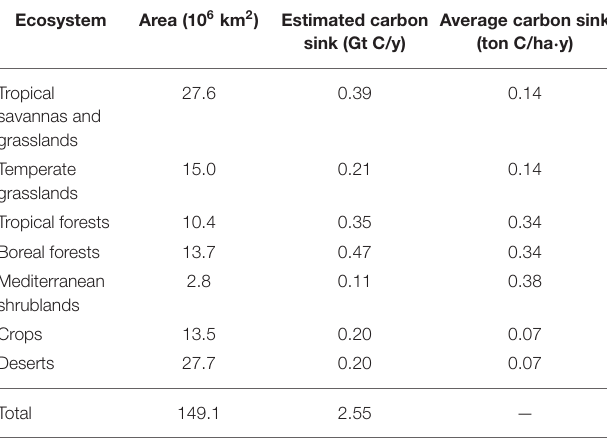
TABLE 2 | Global land area under grasslands and the estimates of C sequestration (Adapted from Grace et al., 2006; Lal, 2008).